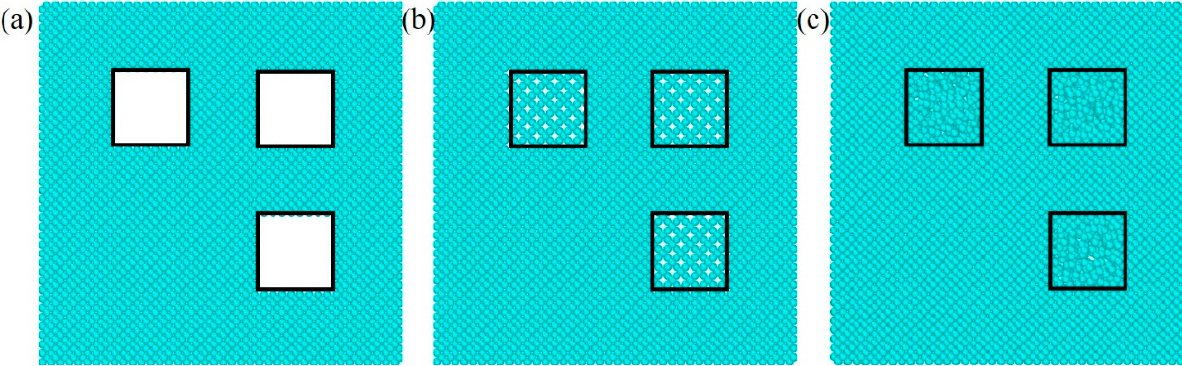
Figure 3. The processed model (2 ‐ 3 ‐ 4): ( a ) perforation; ( b ) concave; ( c ) amorphous.